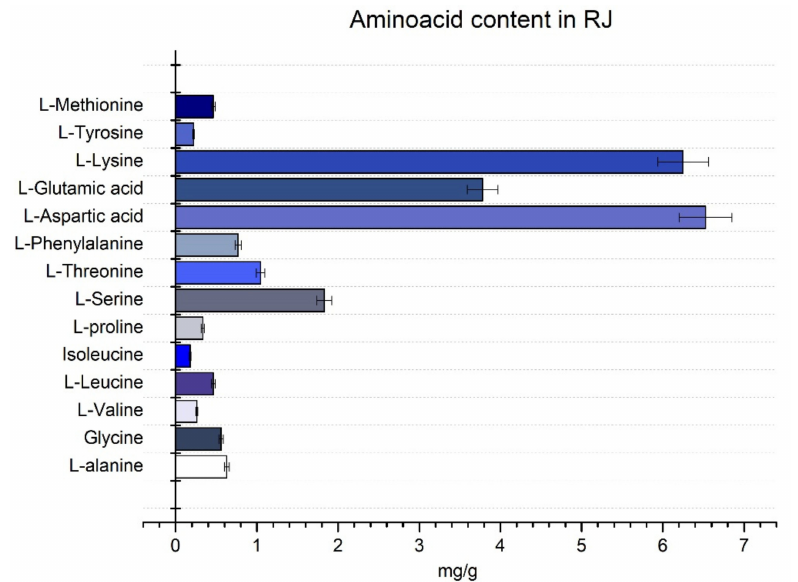
Figure 1. Composition of amino acids in RJ (mg/g).